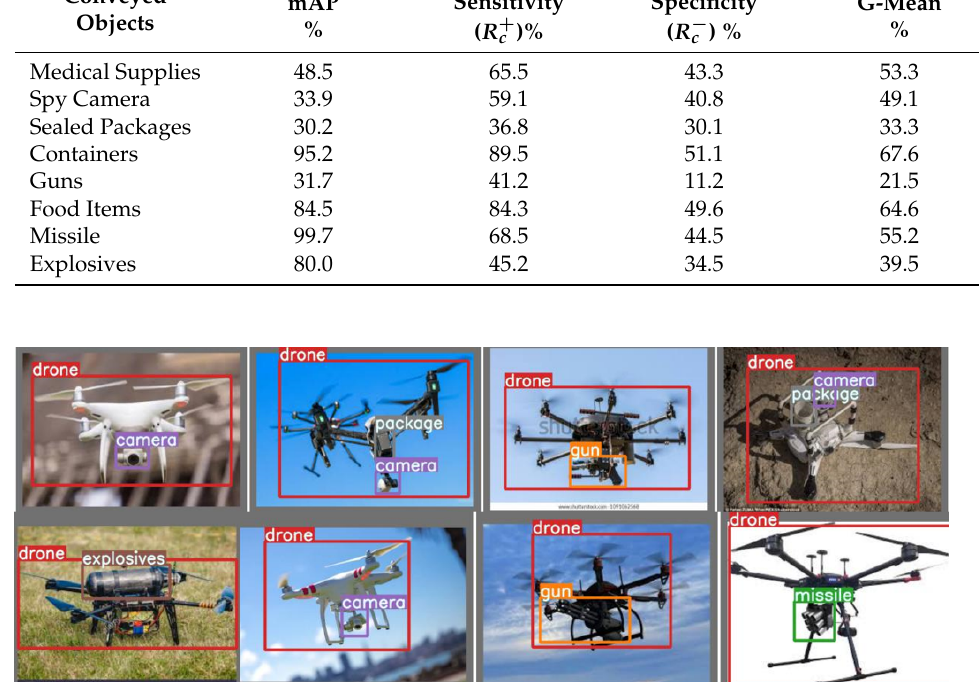
Figure 14. Samples of recognition of conveyed objects by ALIEN.